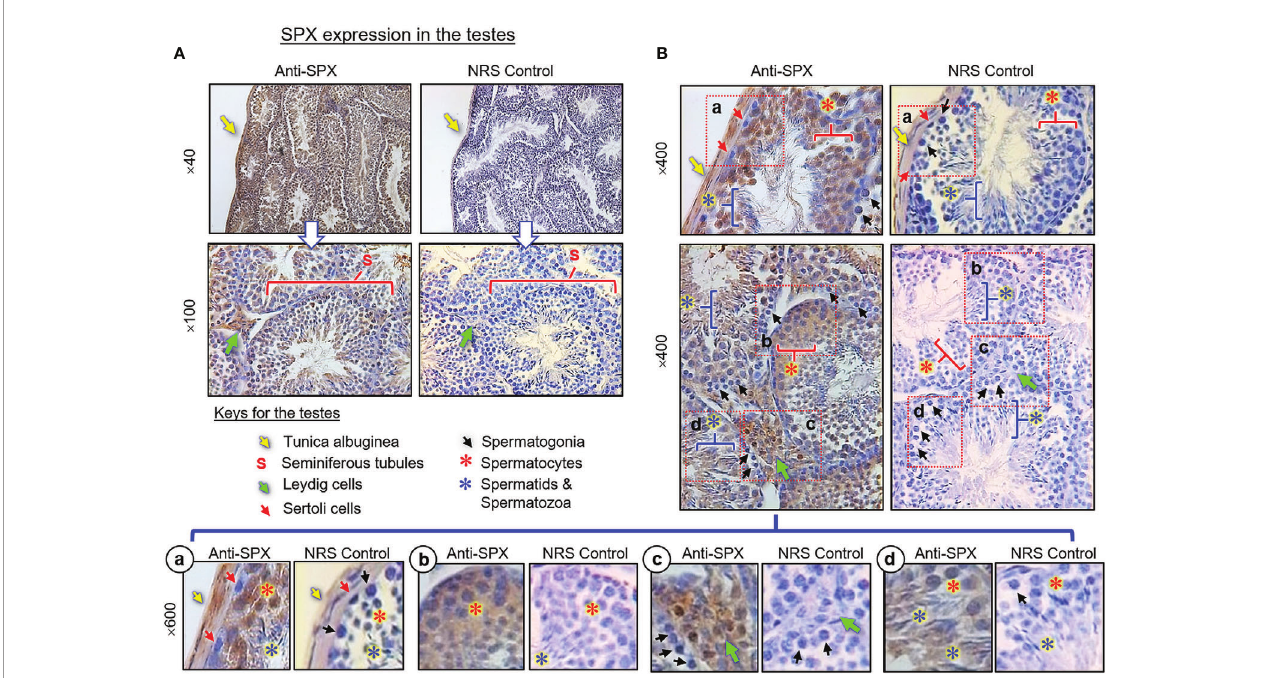
FIGURE 8 | Histological distribution of SPX expression in the testes. (A) SPX immunoreactivity detected by anti-SPX in different regions of the mouse testes, including tunica albuginea, seminiferous tubules and interstitial areas with Leydig cells. (B) SPX expression in different cell types within seminiferous tubules. Except for Sertoli cells and spermatogonia, SPX signals could be noted in the spermatocytes, spermatid and mature spermatozoa ( Subpanel a-d). In this study, parallel staining with NRS was used as the negative control and the numbers on the side (×40, ×100, ×400, and ×600) are the magni fi cation of the respective pictures.